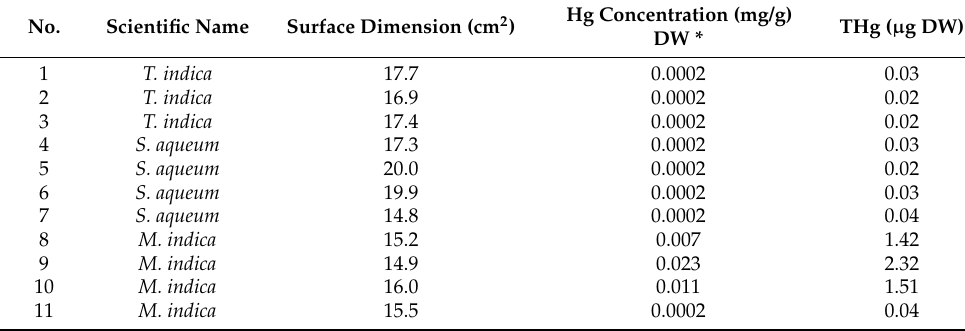
Table 2. Mercury amounts in the control samples.